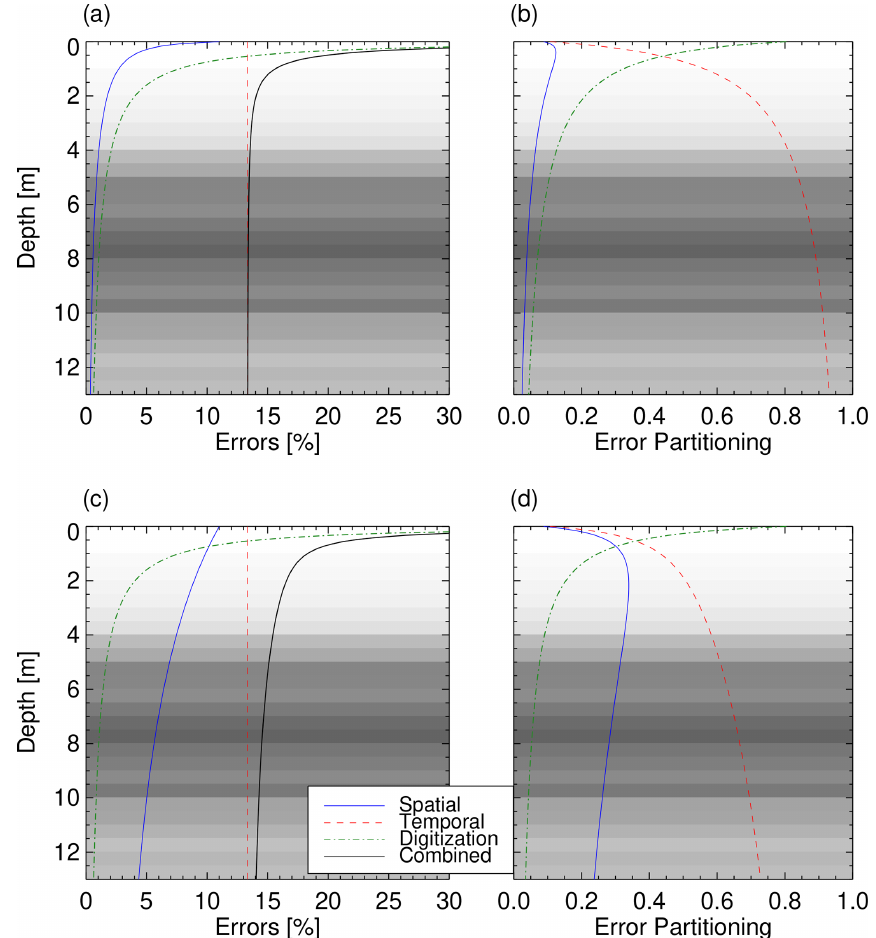
Figure 4. Spatial, temporal, digitization, and combined SMB measurement errors, which relate to the variability in density, dating uncertainty, and ASIRAS sampling accuracy, respectively: relative errors (a, c) and error partitioning (b, d) . Grey background shades indicate the depth distribution of the traced 2005 reflection layer, with darker shading indicating higher number concentrations. (a, b) Based on error propagation according to Eq. (5). (c, d) Excluded spatial error cancellation in Eq. (5) (see main text) and considered for the final error estimation of this